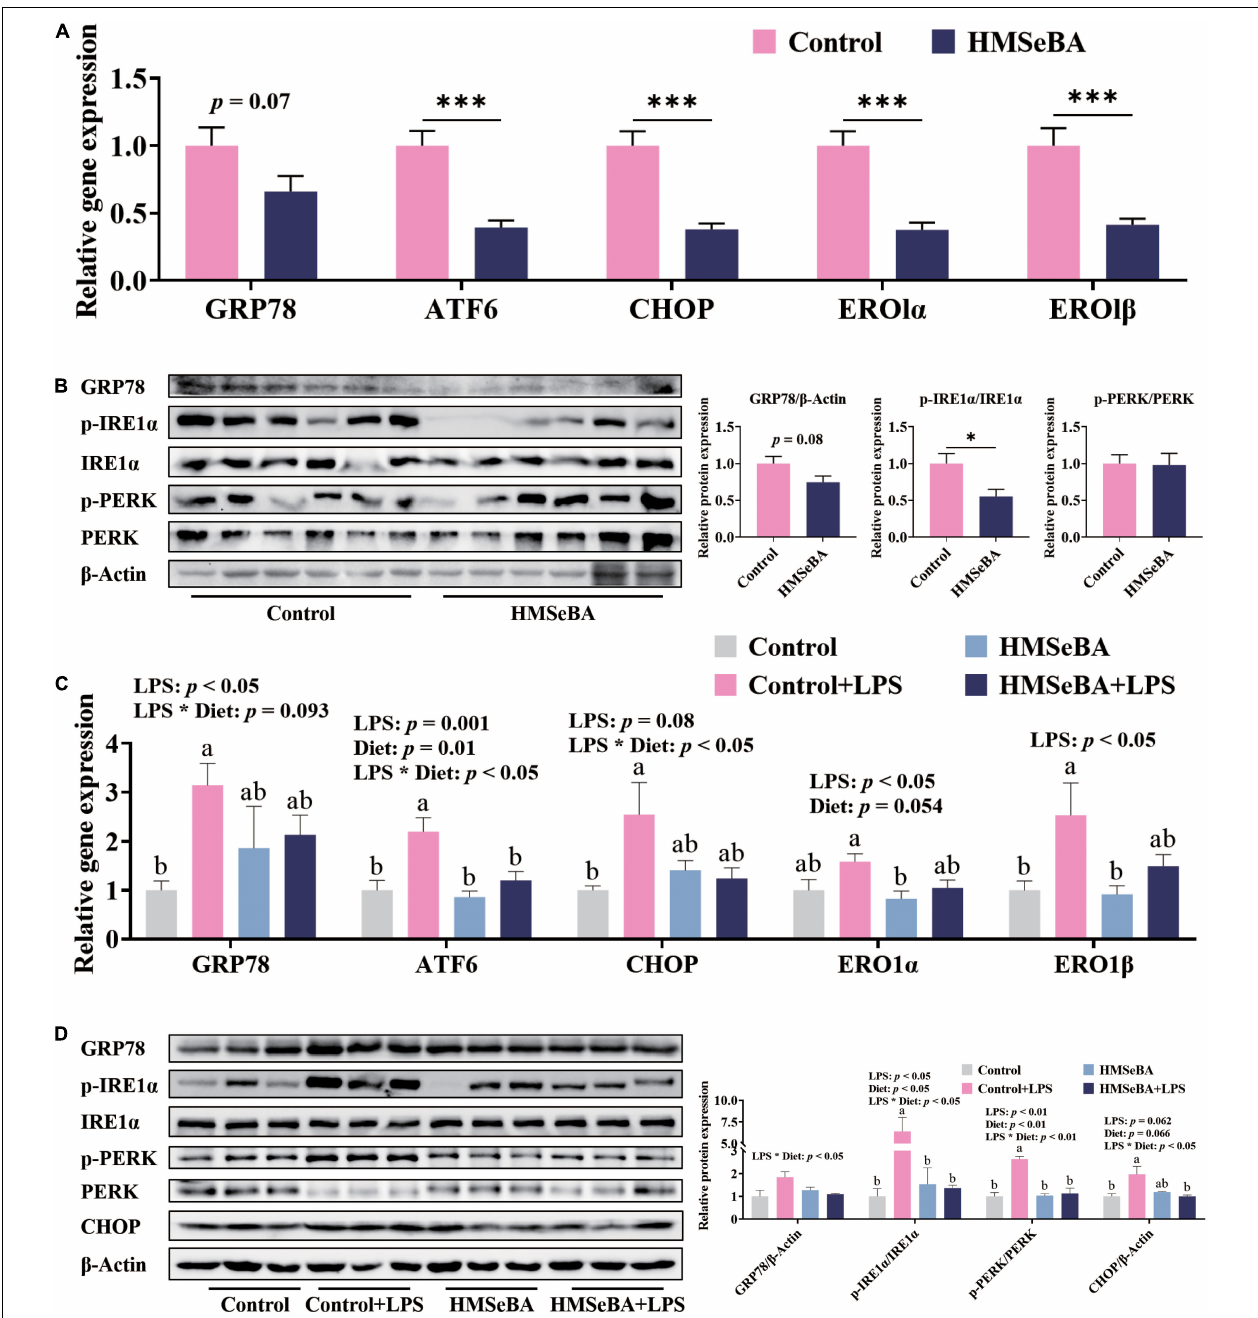
FIGURE 2 | Effect of maternal HMSeBA supplementation during gestation on the expression of ER stress-related markers in the jejunum of piglets. (A) Gene expression of ER stress related markers in newborn piglets. n = 10 per group. (B) Expression of ER stress related proteins determined by western blot in newborn piglets. n = 6 per group. (C) Gene expression of ER stress related markers in weaned piglets. n = 6 per group. (D) Expression of ER stress related proteins determined by western blot in weaned piglets. n = 3 per group. Data are expressed as mean ± SE. ∗ P < 0.05, ∗∗∗ P < 0.001. a,b Values with different superscript letters for same genes were significantly different ( P <